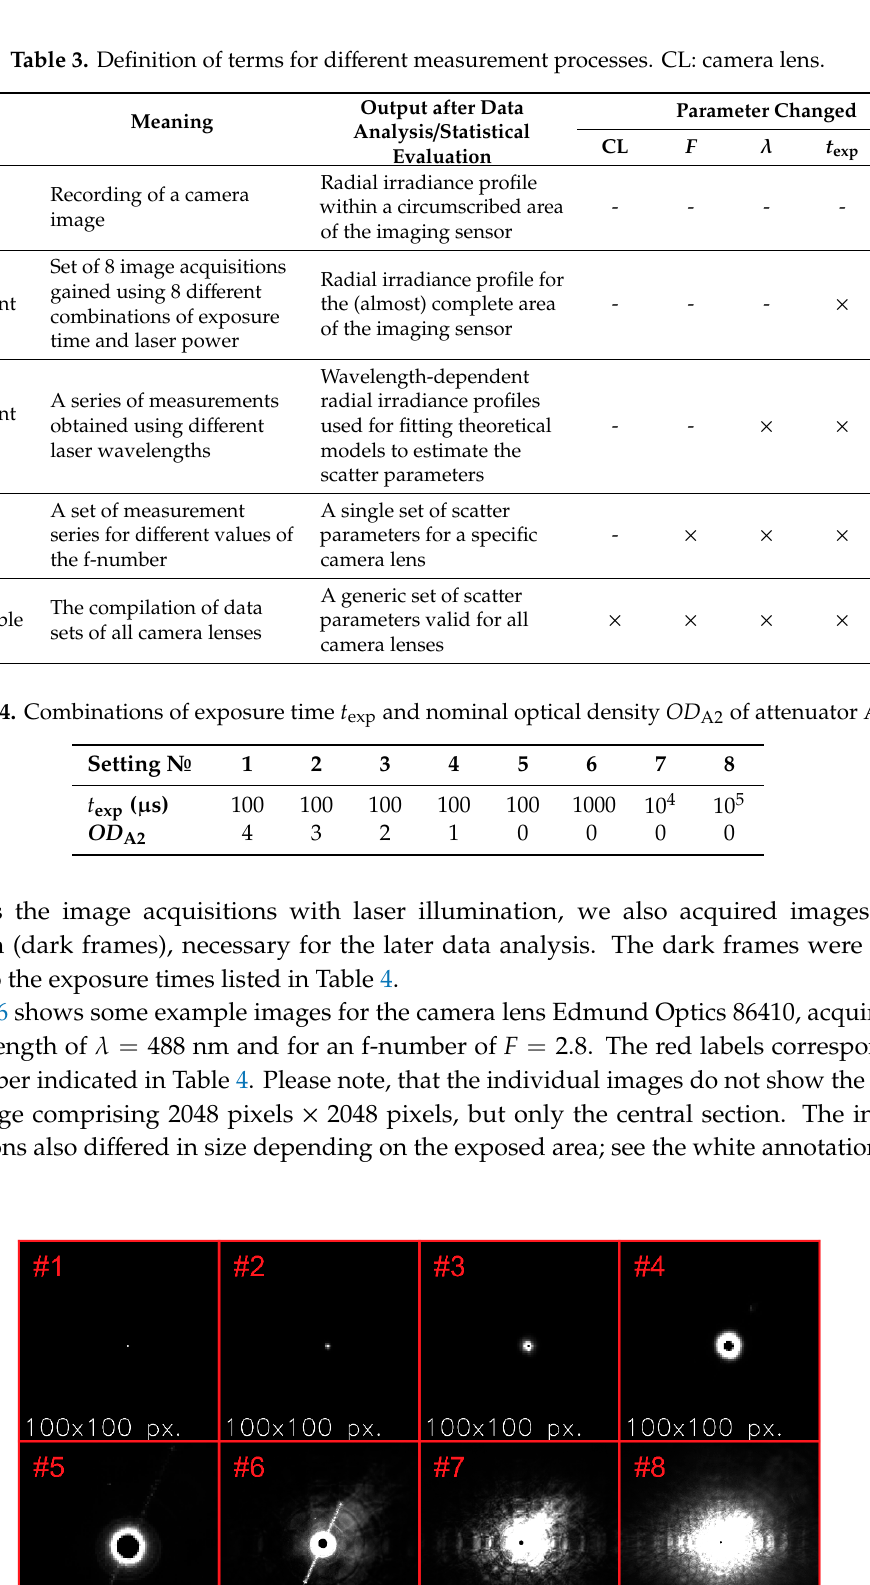
Table 3. Definition of terms for different measurement processes. CL: camera lens.